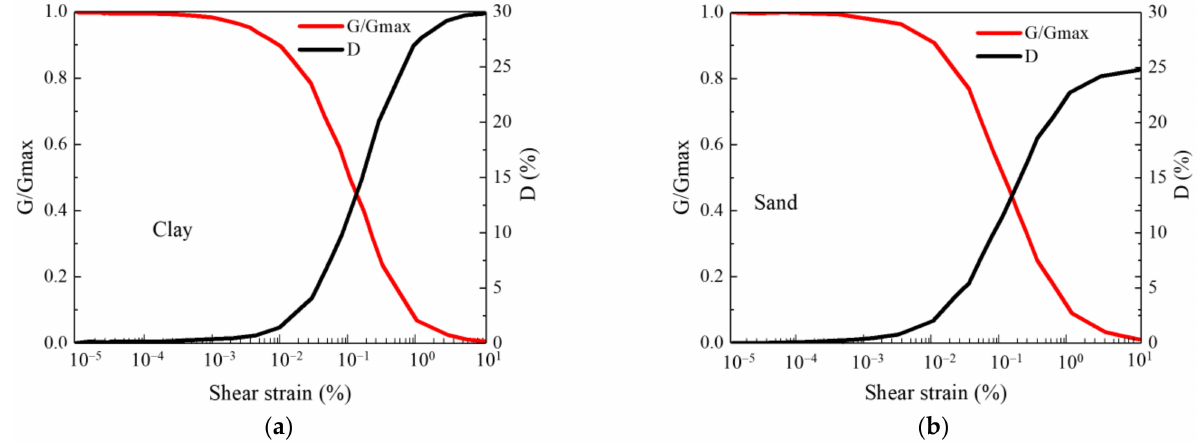
Figure 3. Typical G- γ -D curves for Shanghai soils. ( a ) Clays; ( b ) loose sands.